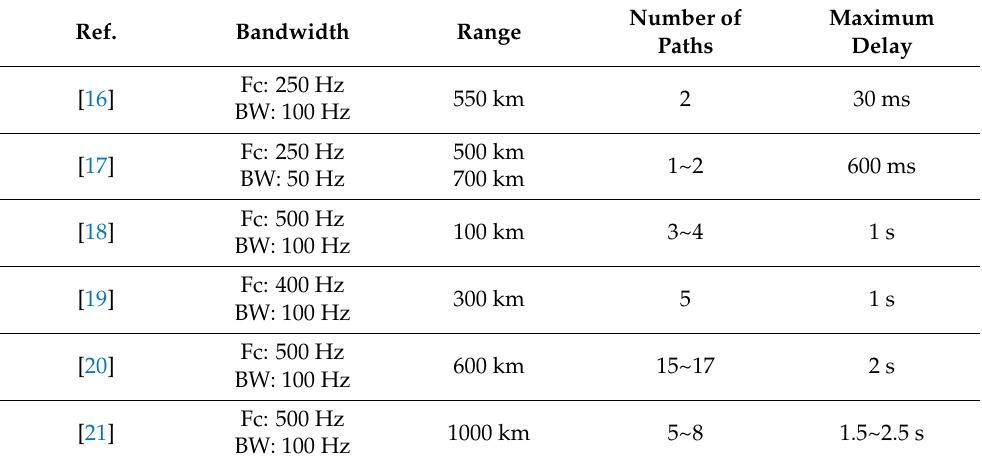
Table 3. Summary of long-range acoustic communication experiment and channel. Ref. Bandwidth